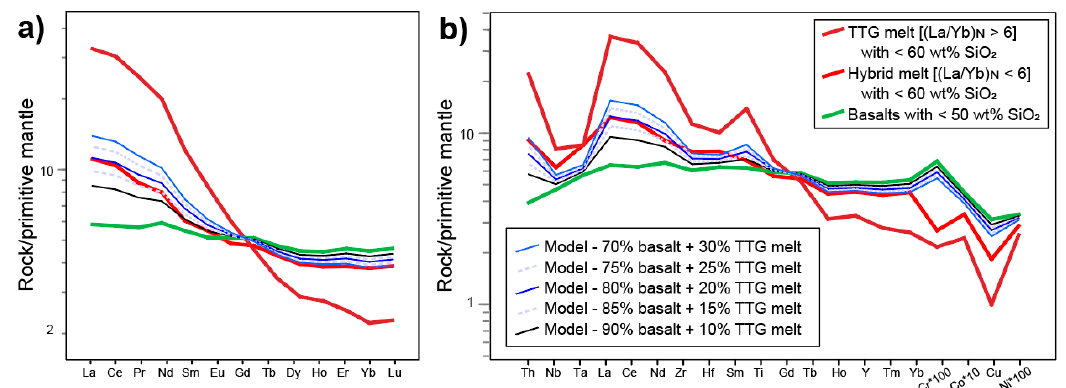
Figure 9. Median values displayed on ( a ) a primitive mantle-normalized [33] REE plot and ( b ) a primitive-mantle normalized [31] multi-element arachnid diagram modified from Pearce [35]. The median values for the least differentiated (<60 wt% SiO 2 ) intermediate-felsic intrusions with (La/Yb) N < 6 ( n = 115) and (La/Yb) N > 6 ( n = 87) are displayed as red lines. Green lines correspond to the least differentiated basalts of the Abitibi Subprovince (Sigeom dataset) with REE, and other trace elements analyzed, and with 45 wt% < SiO 2 < 50 wt% ( n = 913). Modeled melts (blue and black lines) correspond to a mixture of 70% to 90% basalt (~tholeiitic melt) and 30% to 10% least differentiated HREE-depleted rocks (~TTG melt).